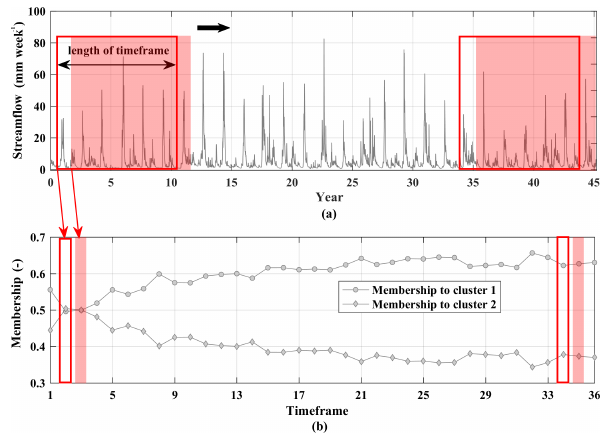
Figure 2. A schematic view to the procedure of identifying the evolution in membership values using a moving window: (a) a decadal timeframe slides over the streamflow time series year-by- year, and (b) membership degrees are recalculated at each decadal timeframe to systematically determine the changes in association to each regime type determined in the beginning of the data